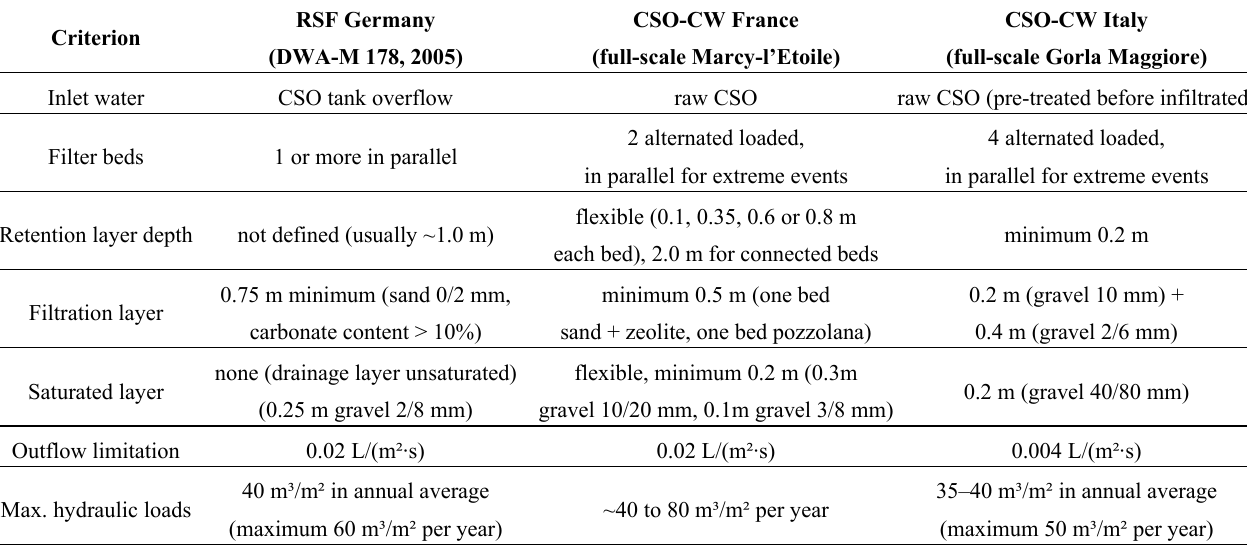
Table 1. Comparison of characteristic design